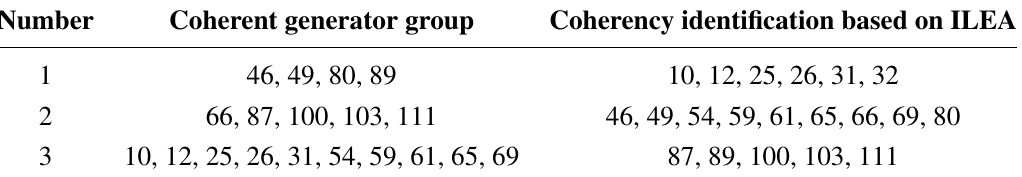
Table 5. Slow coherency grouping and ILEA coherency identification (118-bus).